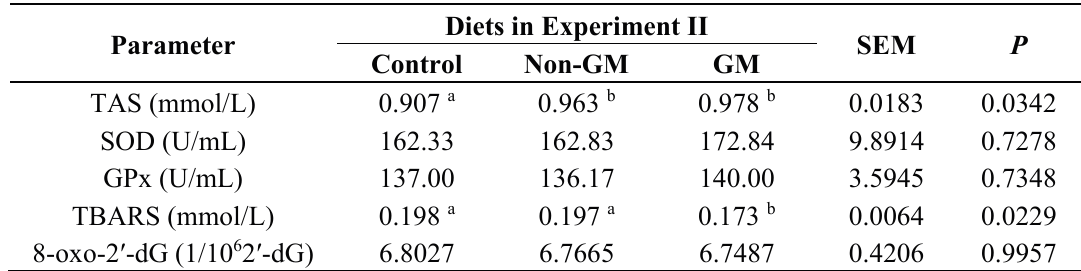
Table 3. Total antioxidant status (TAS) of plasma, activity of superoxide dismutase (SOD) in erythrocytes, activity of glutathione peroxidase (GPx) in plasma, and content of thiobarbituric acid reactive substances (TBARS) and 8-oxo-2 ′ -deoxyguanosine in liver of rats from Experiment II.